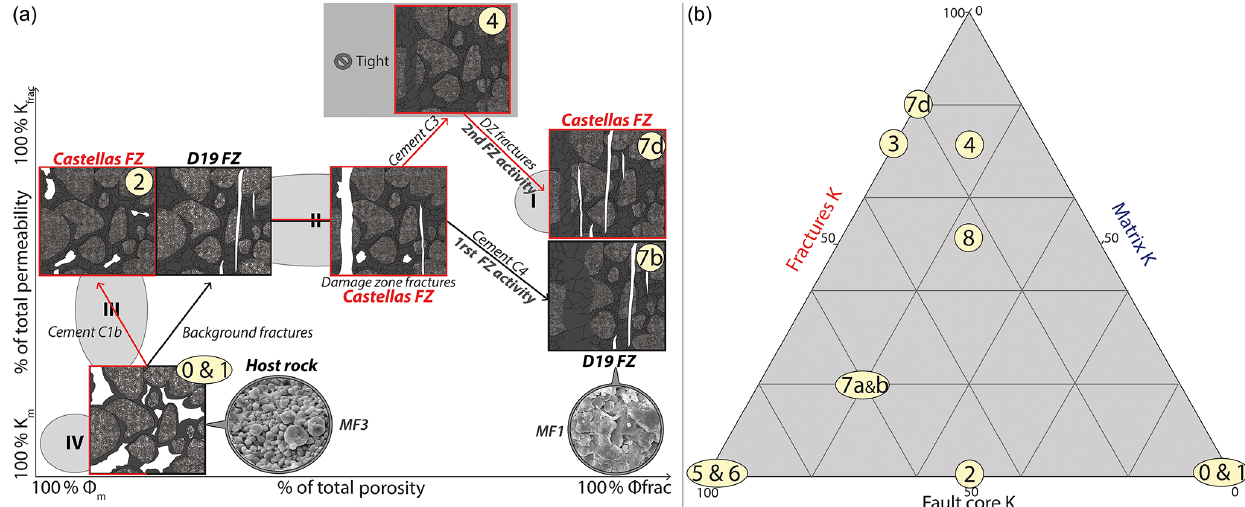
Figure 10. Castellas and D19 Fault zone reservoir properties evolution. (a) Evolution of permeability and porosity taking into account fault zone fractures and matrix after Nelson (2001) and (b) triangle diagram of permeability evolution with three components: matrix, fractures, and fault core. Numbers 1 to 8 correspond to the Steps 1 to 8 (see text for description). K: permeability; (cid:56) : porosity; FZ: fault zone; DZ: damage zone; MF1 and MF3: micrite